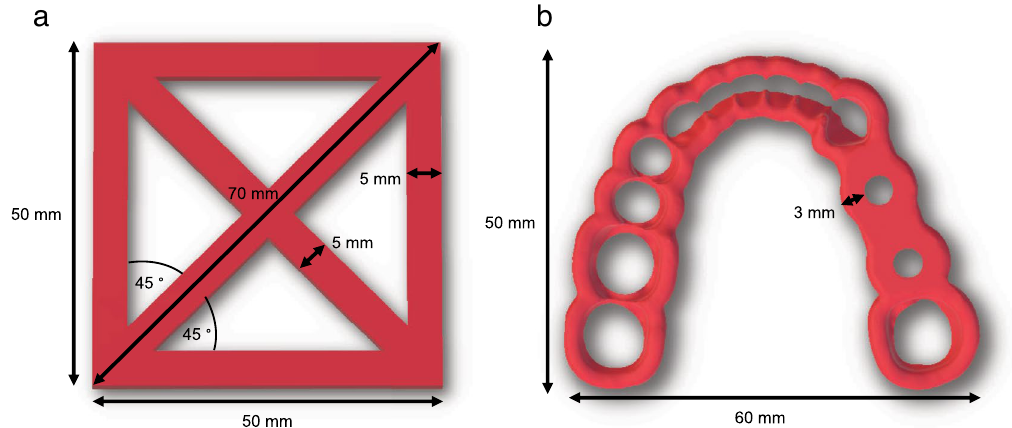
Figure 1. Scheme of the investigated square test specimen ( a ) and of the surgical guide for the placement of oral implants ( b ).